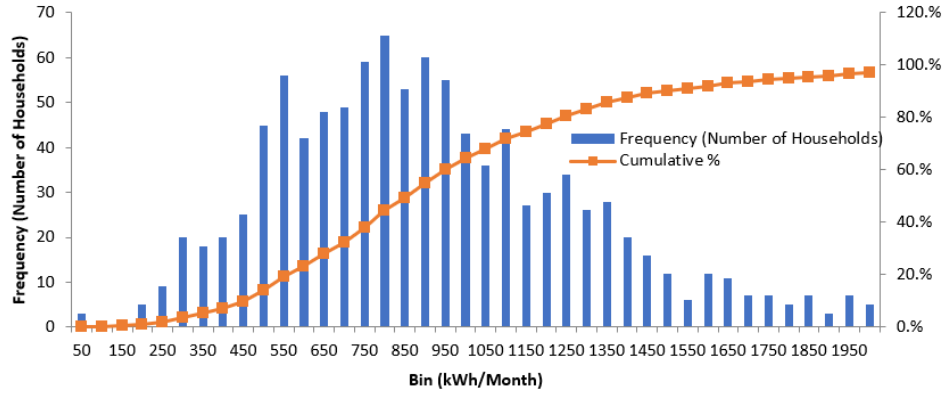
Figure 6. Cumulative % for the ordinary households in January.